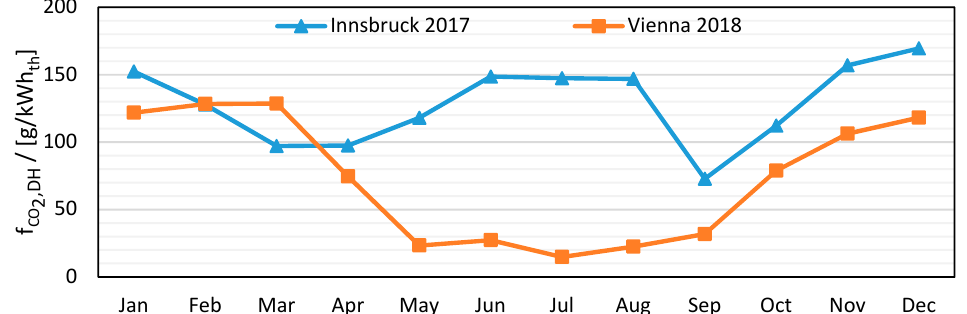
Figure 5. Monthly CO 2 conversion factors for the DH networks of Innsbruck and Vienna including losses derived from measured data from 2017 and 2018, respectively (our own calculations based on [13,12,31], see also monthly energy balance in Figure 2).